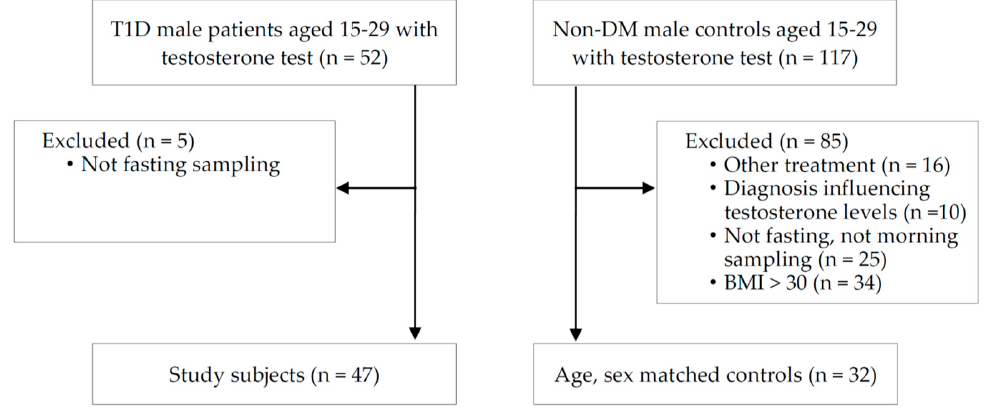
Figure 1. Summary of patient enrollment process and study design. T1D, type 1 diabetes; BMI, body mass index; DM, diabetes mellitus.